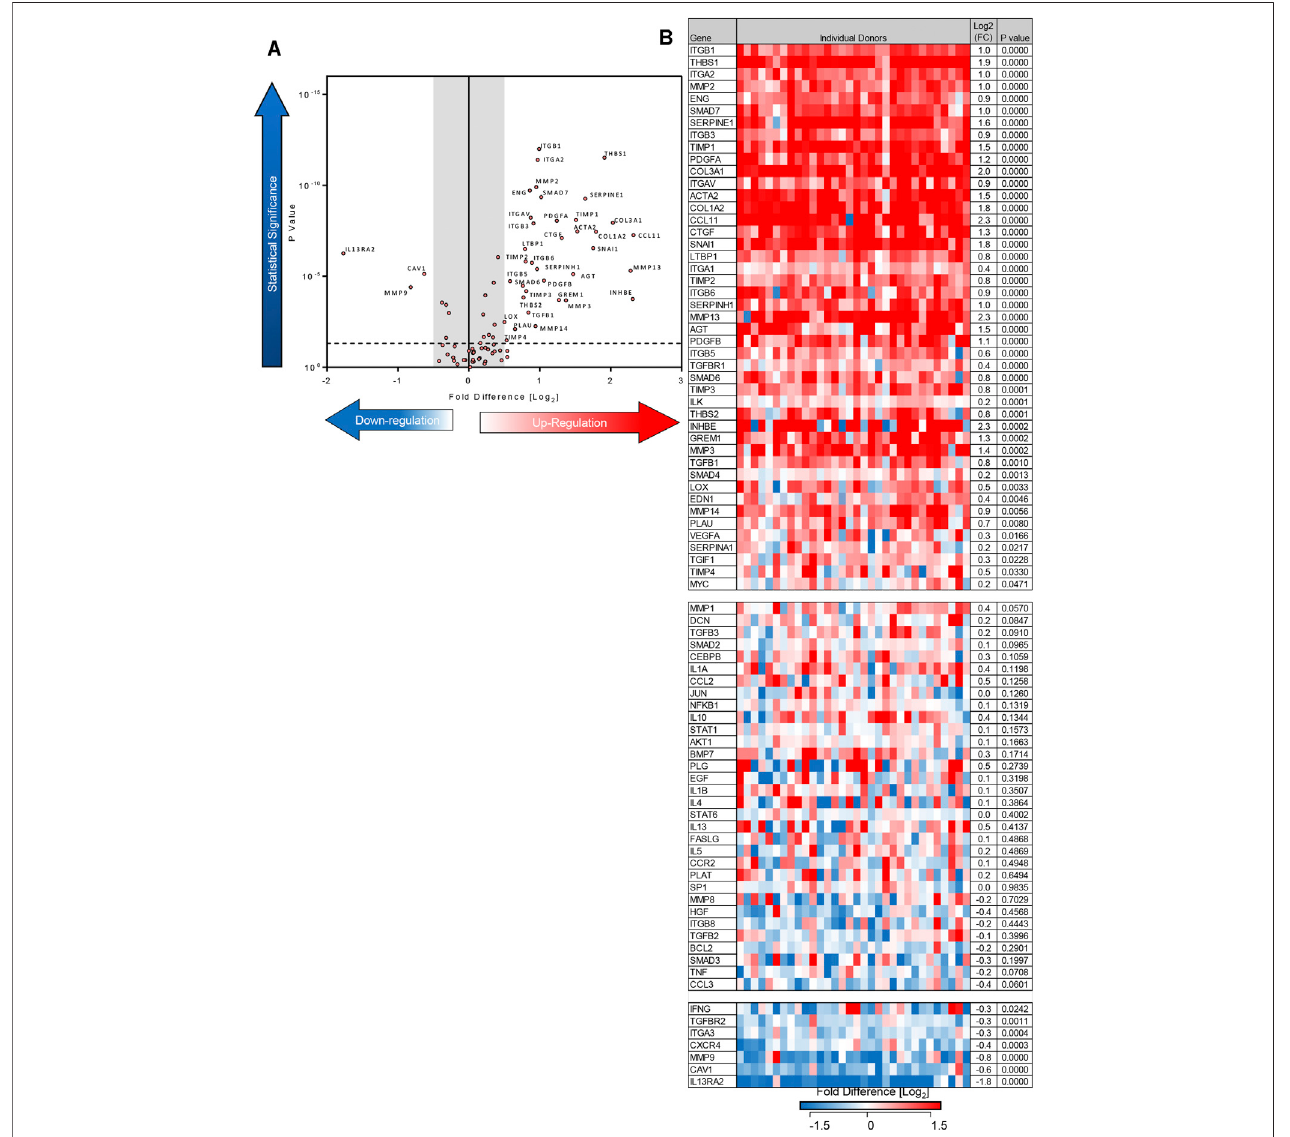
FIGURE2| Differentiallyexpressedgenesinhumanlungparenchymaafter7 daysstimulationwithTGF β 1comparedtocontroltissue. (A) Avolcanoplotidentifying the statistically signi fi cant genes regulated by TGF β 1 shown as p value versus log 2 FC. Out of 84 genes, 36 were signi fi cantly upregulated and three downregulated followinga5%falsediscoveryanalysiswithJohnD.Storeyadjusted p value < 0.05andabsolutevalueoflog 2 FC ≥ 0.5,depictedbythedottedlinesandgreyshadedarea (results are mean of 32 individual donors). (B) The log 2 FC of all 84 genes in individual donors is depicted in this heatmap, with mean log 2 FC, and statistical signi fi cance indicated. Signi fi cance was calculated using a student ’ s t-test on the ΔΔ CT for each gene.